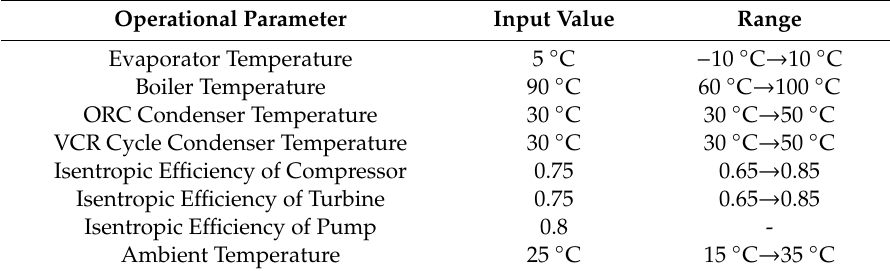
Table 2. Input values and ranges of operational parameters used in first system.